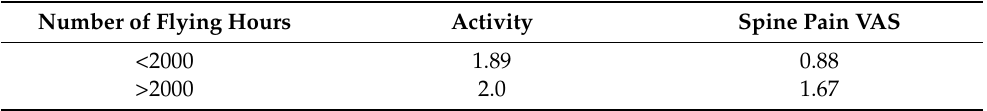
Table 2. Data on the number of flying hours, the physical activity and the symptoms of the spine pain evaluated in VAS among 19 studied